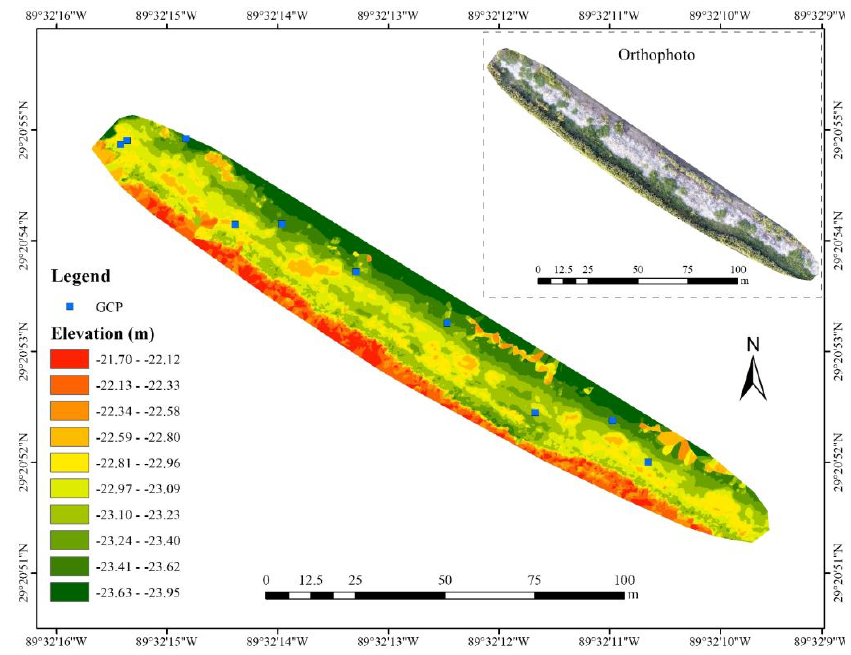
Figure 6. Orthophoto and DTM generated from UAV images acquired on 1 October 2015.